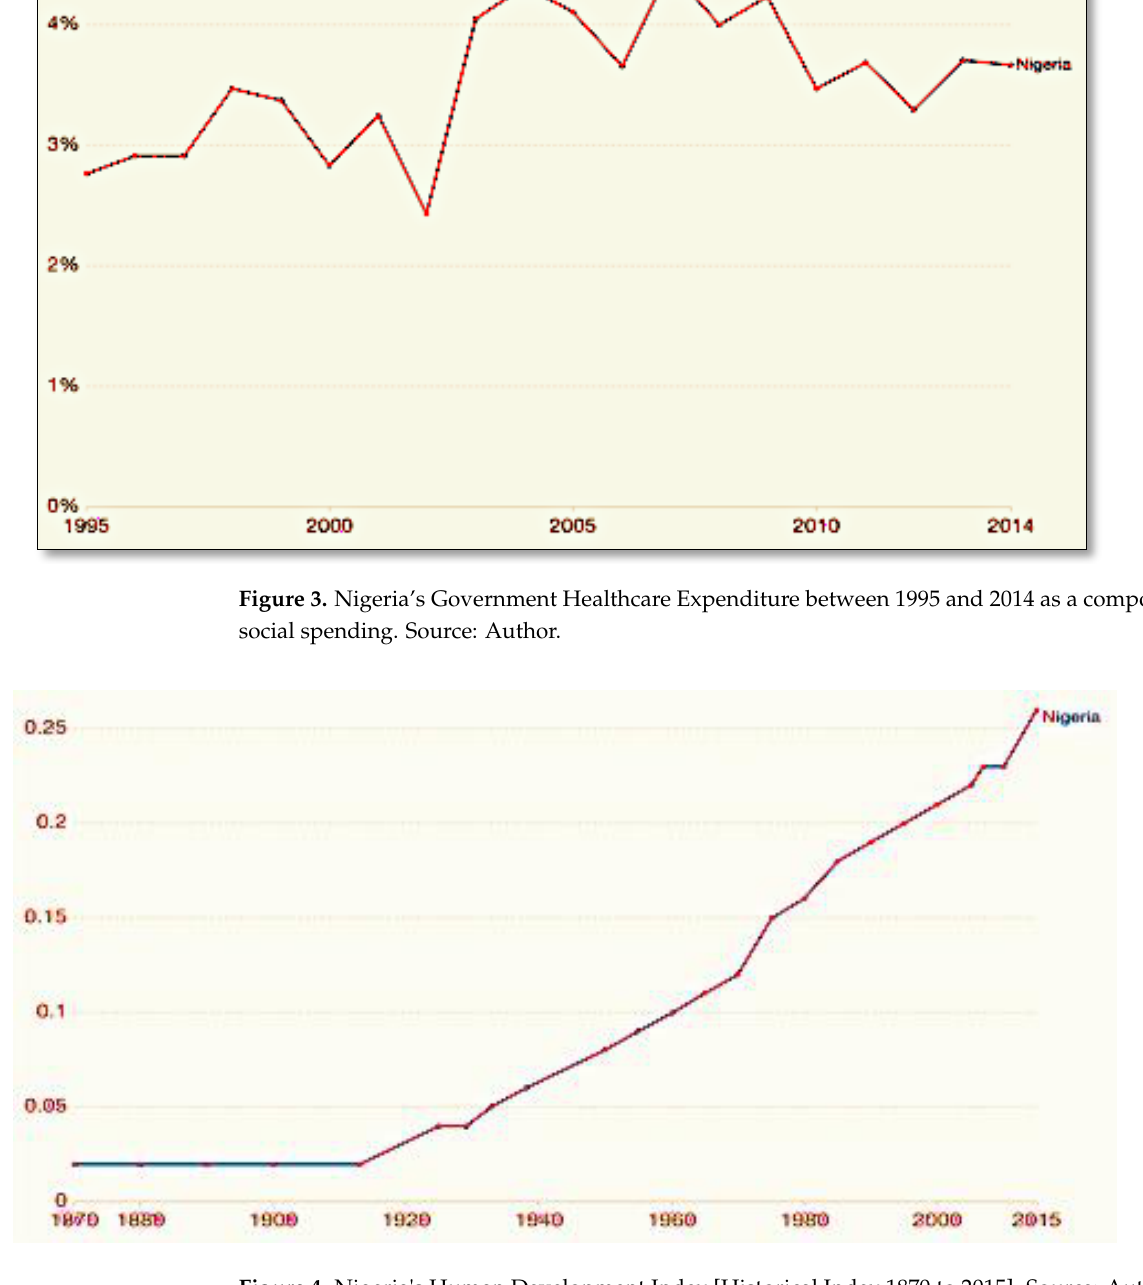
Figure 5. Nigeria's GDP Growth Rate [January 2017 to January 2020]. Source: Trading Economics, 2020. Iversen [70] argued that scholars of the developmental welfare states grapple with understanding them as the intersection of democracy and capitalism. However, this argu- ment misses the point, especially where democracy in a polity is non-existent and where welfare capitalism is retarded. Unfortunately, the reality of citizens in these contexts demonstrate they have to function under far more ‘ constrained burdensome conditions ’ of institutional welfare choice, and contexts where the government can scarcely be trusted at all, even in a hegemonic sense, for simple law and order as a precondition for private decisions about wellbeing and security [71]. In a broader sense, resorting to informal wel- fare and social security becomes the norm in these ‘ insecure ’ , ‘fragile states’ with ‘ imper- fect well-being regimes ’ [72]. Putting this in perspective also entails understanding how